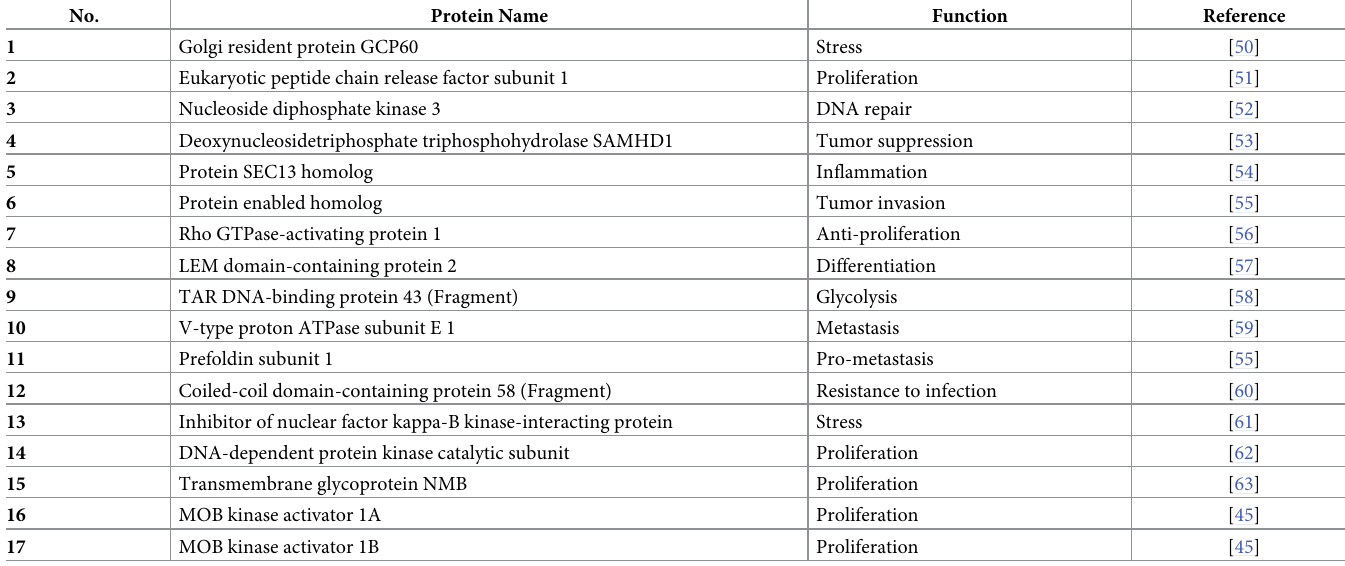
Table 5. List of proteins functions identified in stage 3 breast cancer samples.